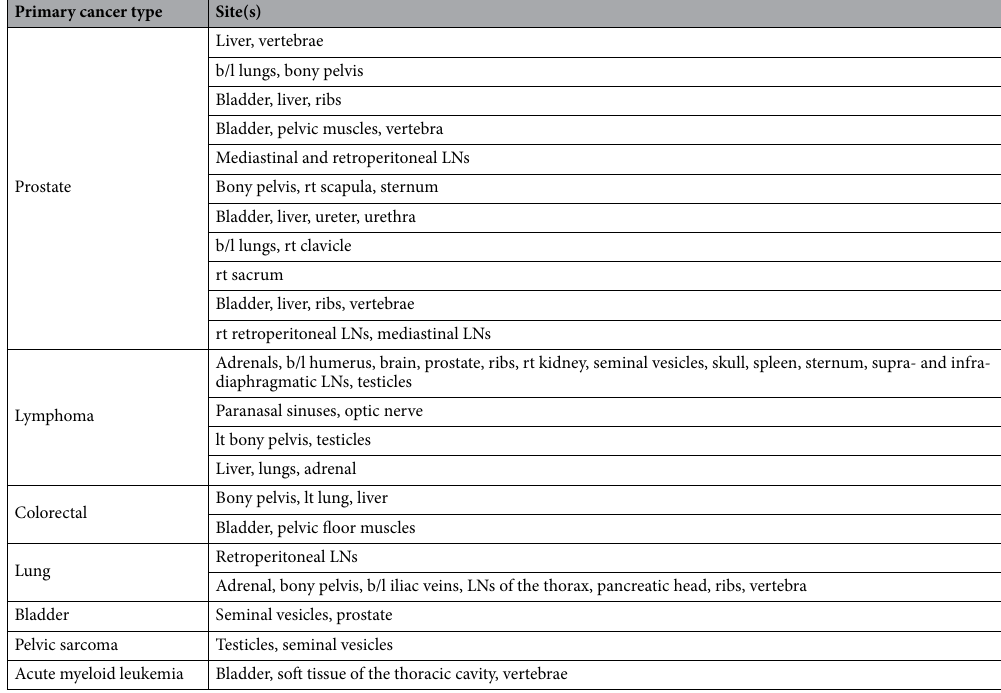
Table 2. Sites of extra-penile pathological findings on PET/CT. b/l bilateral, rt right, lt left, LN lymph